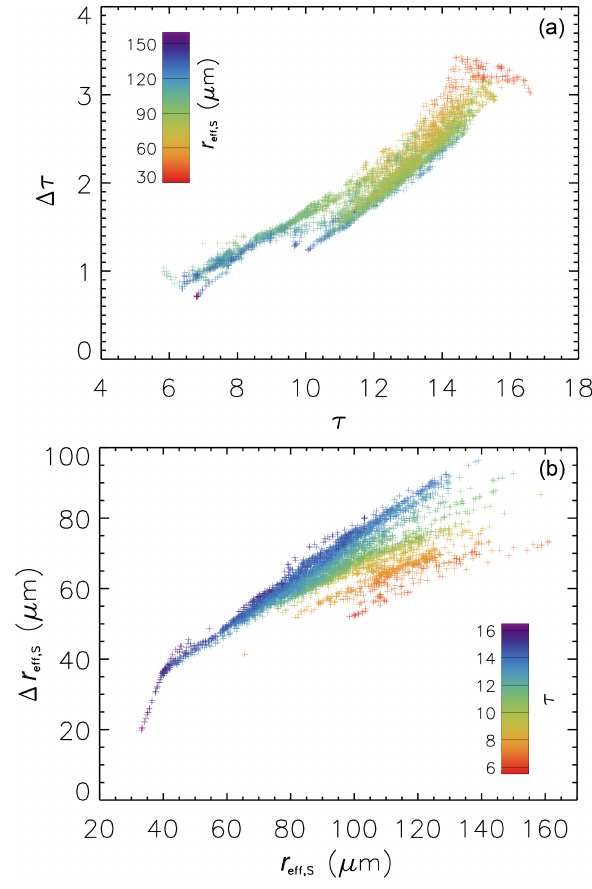
Figure 7. Uncertainties (cid:49)τ (a) and (cid:49)r eff , S (b) as a function of re- trieved τ and r eff , S . The single measurements are colour coded with r eff , S for (a) and τ for (b)